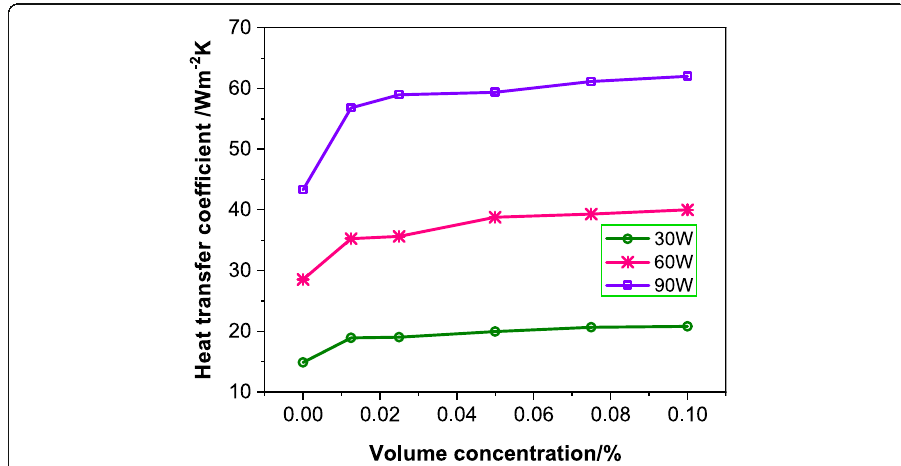
Fig. 8 Heat transfer coefficient of Al 2 O 3 – SiO 2 nanofluids as a function of heat input and volume